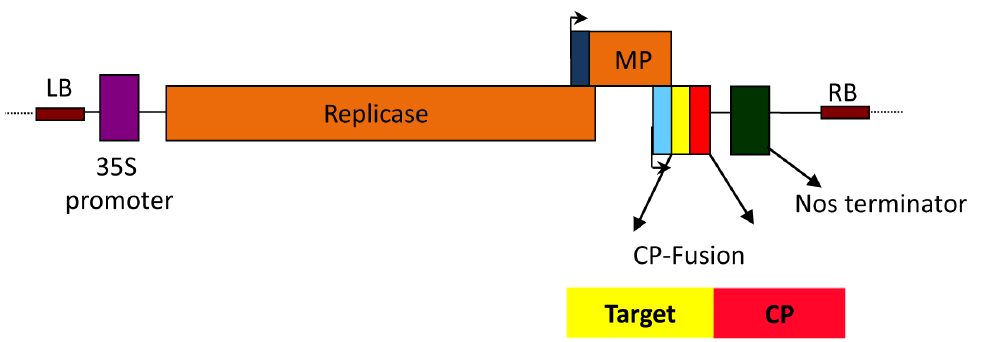
Figure 1. Schematic diagram of the ‘launch’ vector. Following agroinfiltration of plants, the sequence between the left border (LB) and the right border (RB) of the plasmid vector is transferred from Agrobacteria into plant cells where expression of the engineered TMV genome is driven by the Cauliflower mosaic virus (CaMV) 35S promoter. TMV replicase then drives amplification of primary transcript, and Pfs25-CP accumulation is then driven by the TMV CP subgenomic promoter (light blue box). Movement protein (MP) facilitates cell-to-cell transfer of viral sequences and is driven by the MP subgenomic promoter (dark blue box).